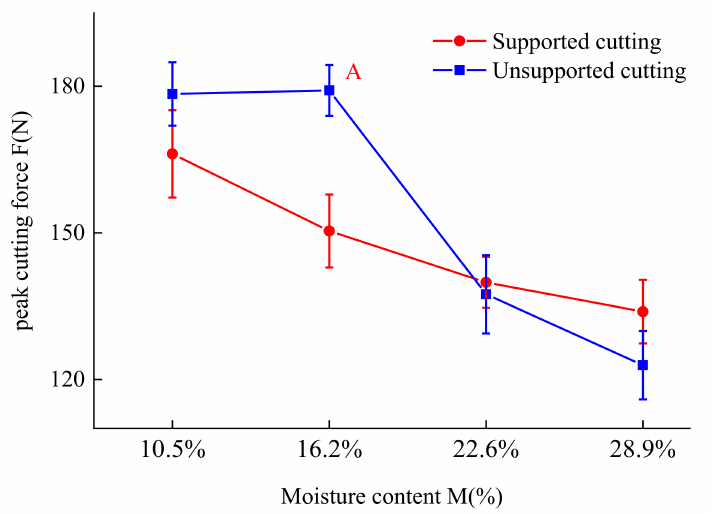
Figure 19. Relationship between moisture content and peak cutting force. Note: branch diameter is